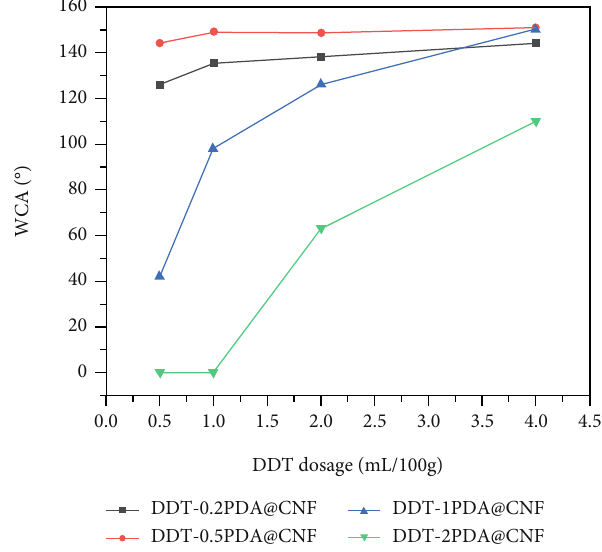
Figure 3: The WCA of composite aerogels with di ff erent DDT loading